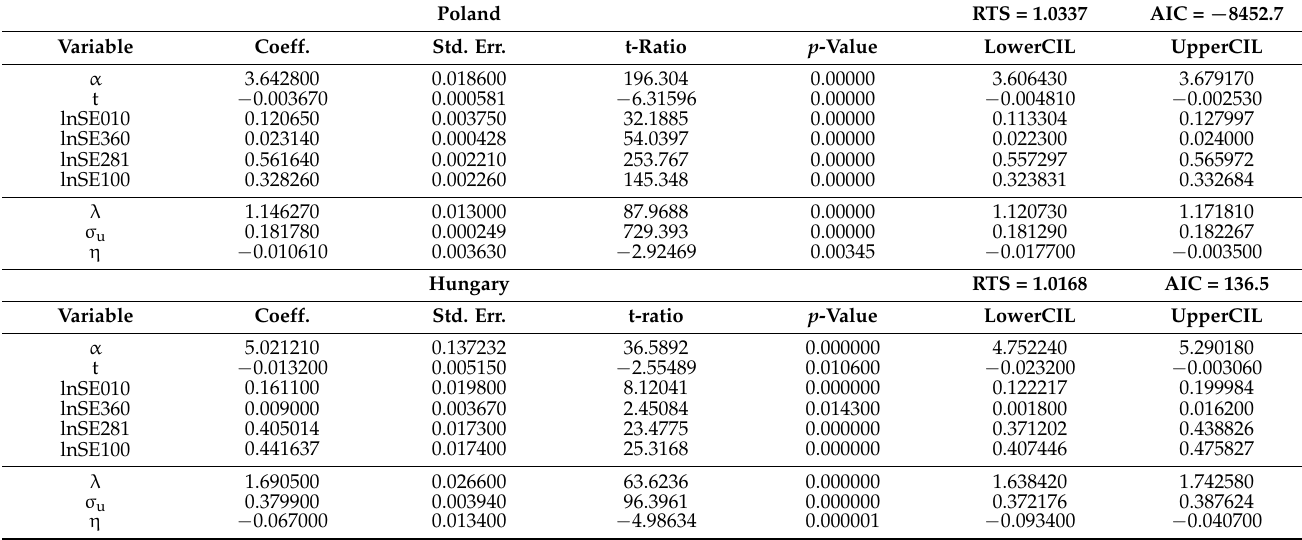
Table A1. Parameter estimates for the Cobb–Douglas function as well as the Battese and Coelli (1992)